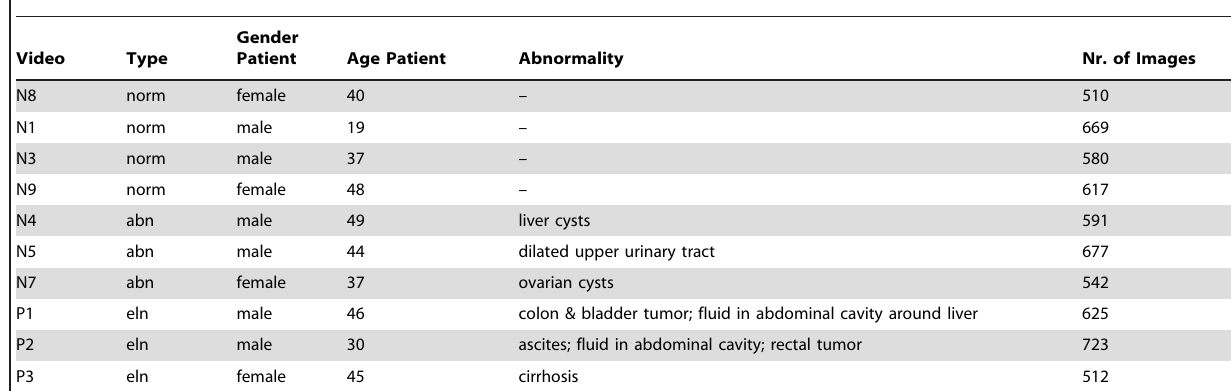
Table 1. Patient information for each video used in the experiment.